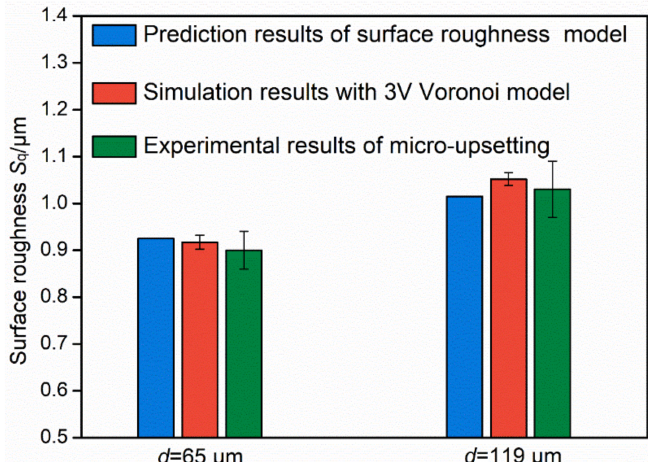
Figure 20. Comparison between model prediction, simulation, and experimental results for different grain